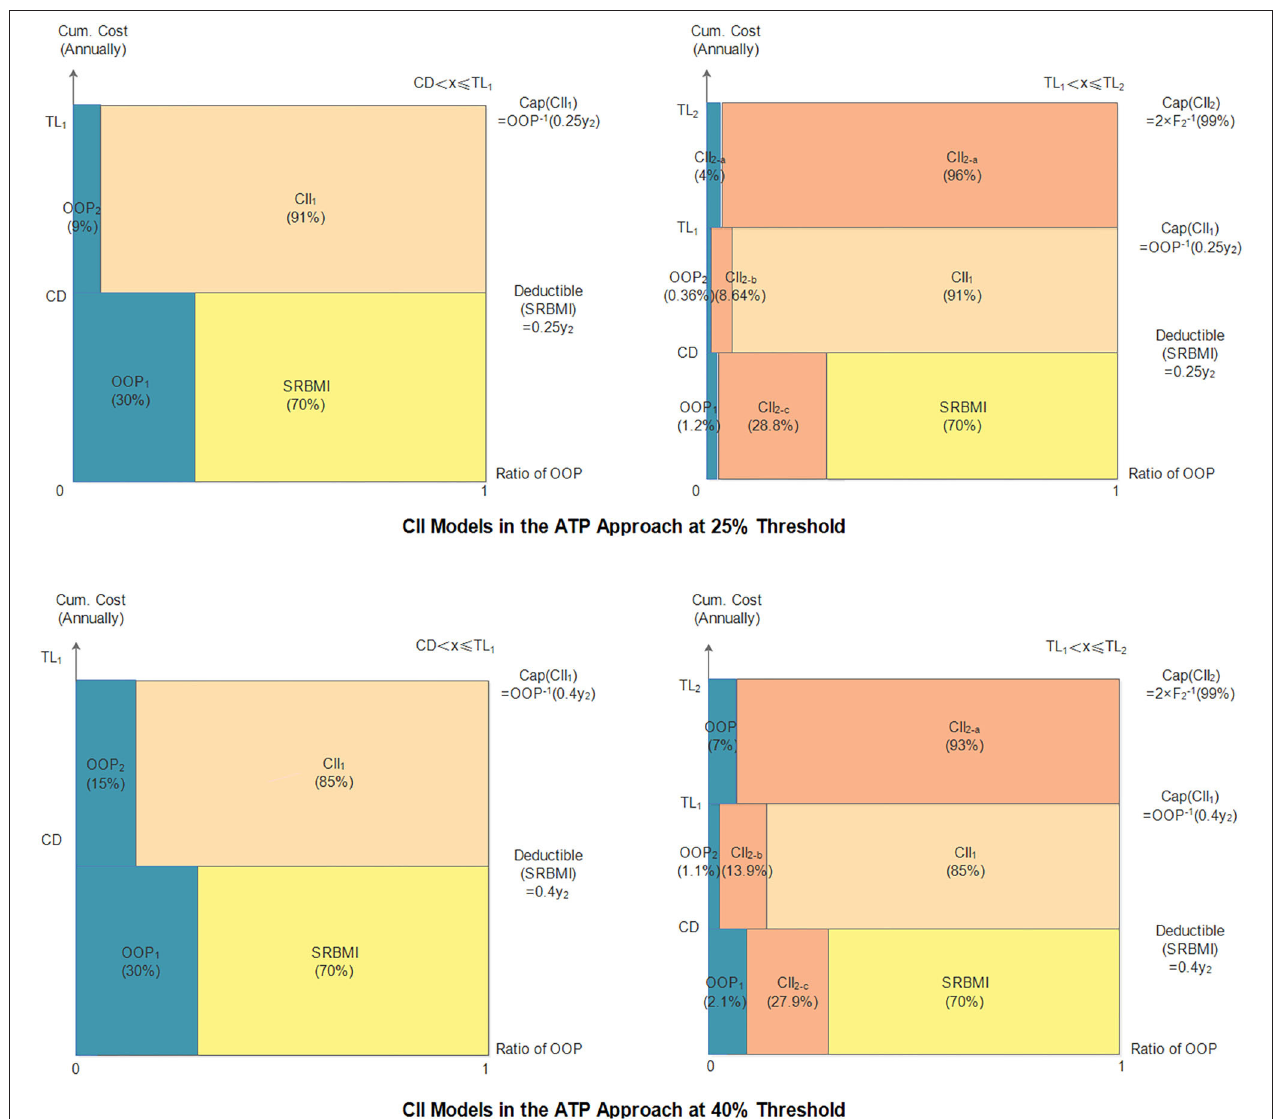
FIGURE 4 | CII models in the ATP